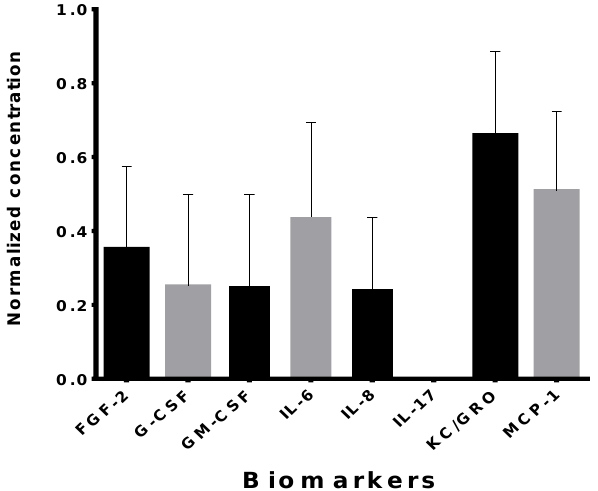
Figure 7. Biomarkers, normalized concentration of each biomarker in the conditioned medium of eSM-MSCs P4 (mean ± SEM).